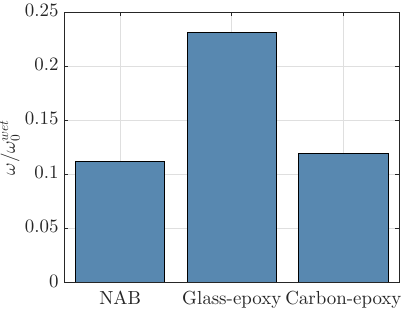
Figure 3. Structural frequency ratios for the various Seiun–Maru